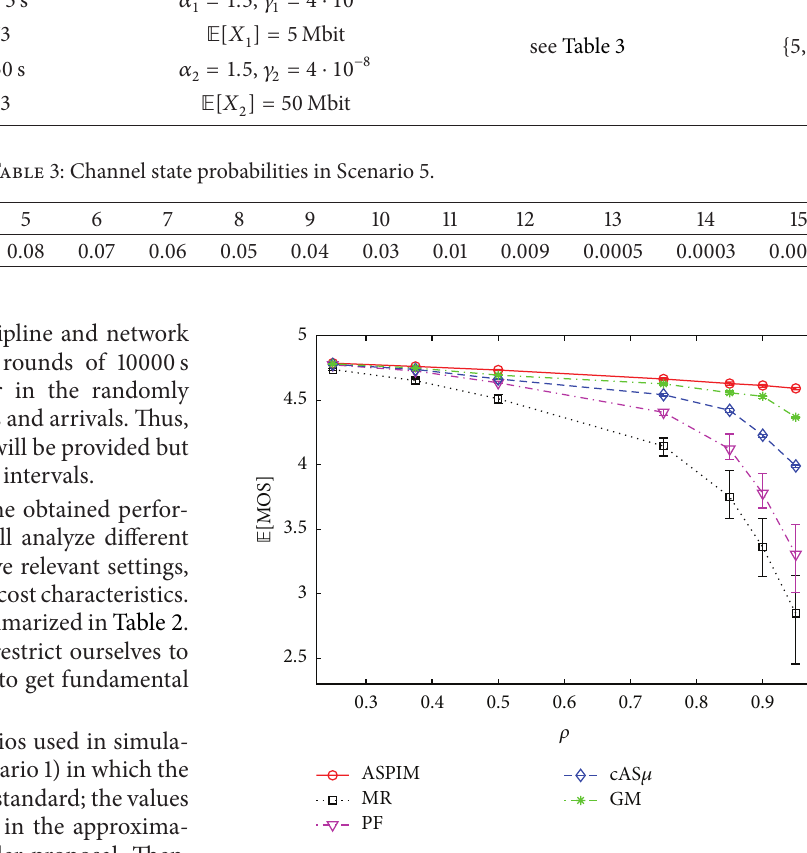
Figure 5: E [MOS] for the basic